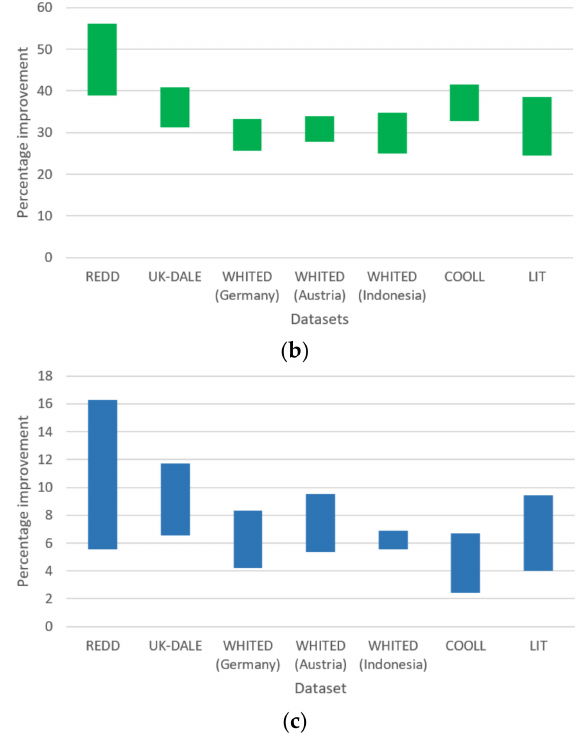
Figure 3. Summary on the range of percentage improvements between models: ( a ) between the proposed model and standalone CEEMD, ( b ) between the proposed work and standalone WPT, and ( c ) between standalone CEEMD and standalone